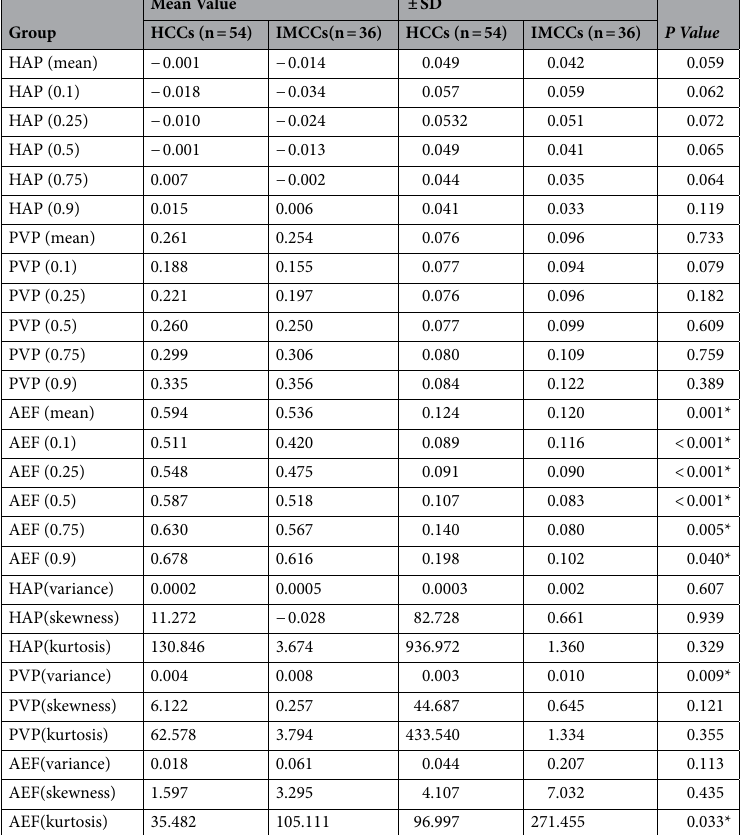
Table 2. Liver perfusion parameters and histogram parameters for patients with IMCCs and HCCs. *Statistically significant difference between the two groups (P < 0.05). HAP hepatic artery